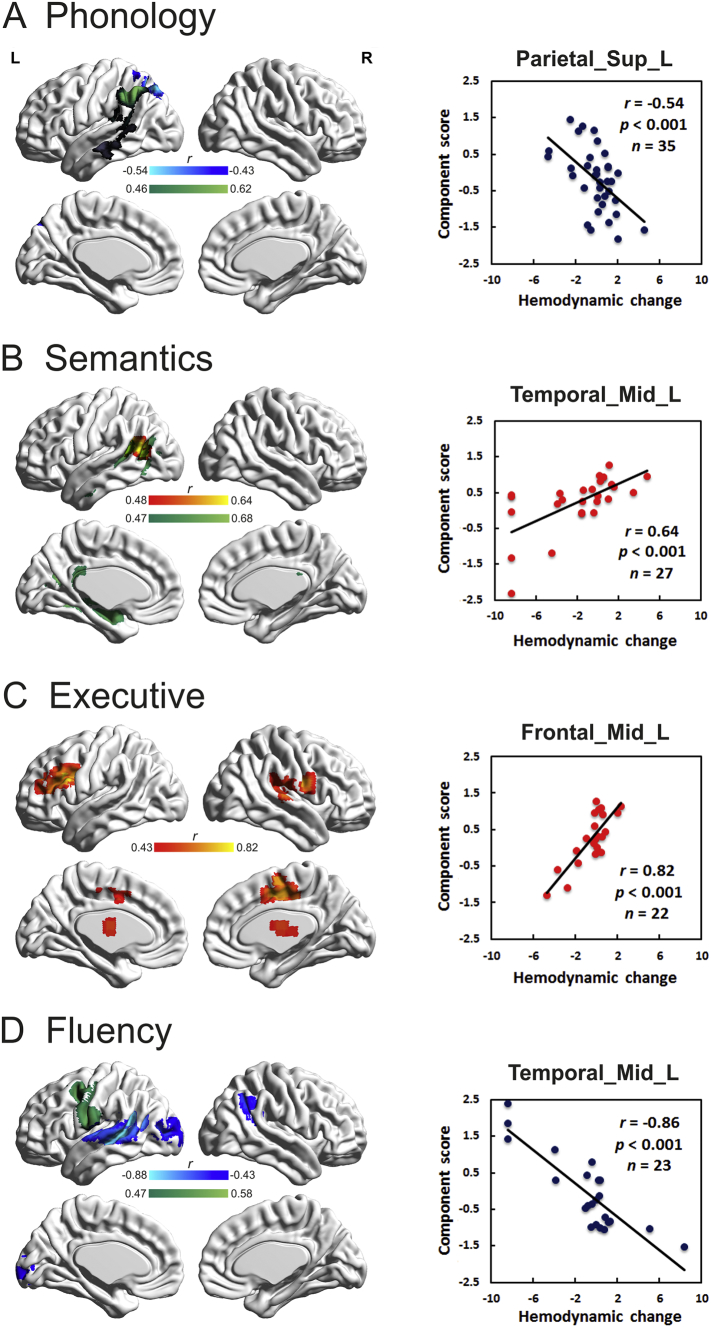
The left column shows voxel-wise correlations between hemodynamic changes/ grey matter intensity and factor scores. For correlations with hemodynamic changes, positive correlations indicating delay are shown in red; while negative correlations indicating advance are shown in blue (Alphasim cluster corrected p < 0.01 with voxel p < 0.01). Results of correlational analyses between grey matter intensity and factor scores are shown in green (Alphasim cluster corrected p < 0.01 with voxel p < .005). For phonology, dark grey indicates clusters that survived at a lower the threshold (Alphasim cluster corrected p < 0.01 with voxel p < 0.01). The right column shows the scatter plots of the peak voxel as an example to help with interpretation. (For interpretation of the references to colour in this figure legend, the reader is referred to the web version of this article.)